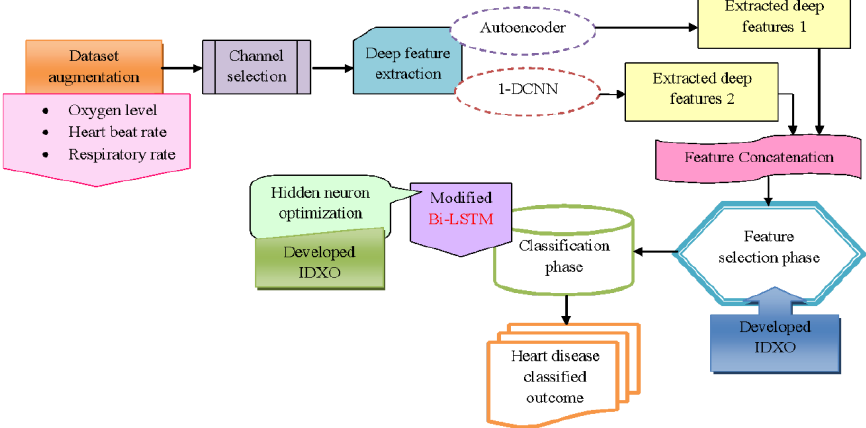
Figure 1. Diagrammatic representation of designed heart disease prediction model in WBAN.